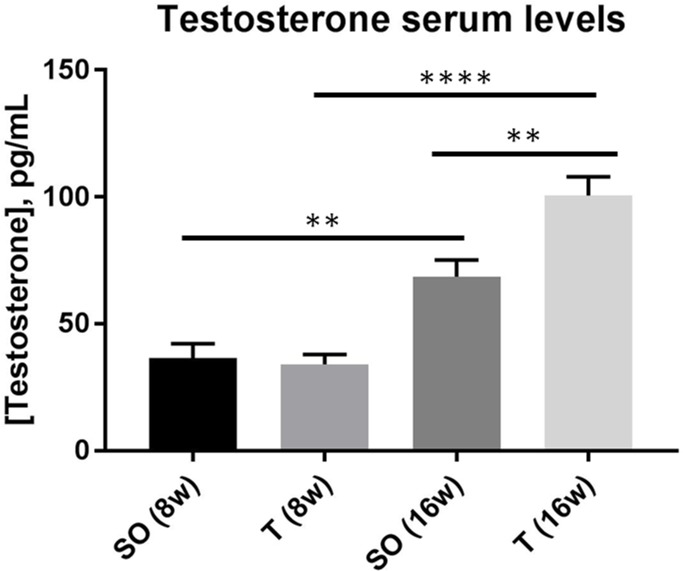
Serum testosterone concentration is significantly higher in adult, but not early adolescent, prenatally androgenized rats compared with controls.Sprague-Dawley rats were prenatally exposed to sesame oil or 5mg testosterone each day during gestation days 16–19. Serum samples, collected by tail vein blood draw at 8 and 16 weeks of age, were assayed by ELISA for T. No significant difference in [T] was detected at 8 weeks of age, but rats prenatally exposed to testosterone exhibited significantly greater [T] as young adults compared to rats exposed to sesame oil, with a 30% greater level in the PNA rats (16 weeks of age, n = 8 for each group, 2-way ANOVA with Tukey’s, ** p < 0.01, **** p < 0.0001). Values are means ± SEM. SO, sesame oil prenatal exposure; T, testosterone prenatal exposure.